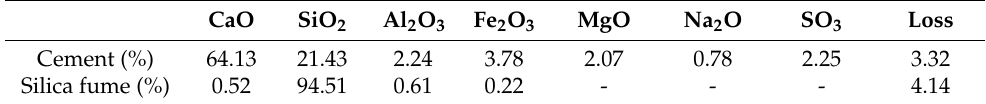
Table 2. Chemical properties of raw